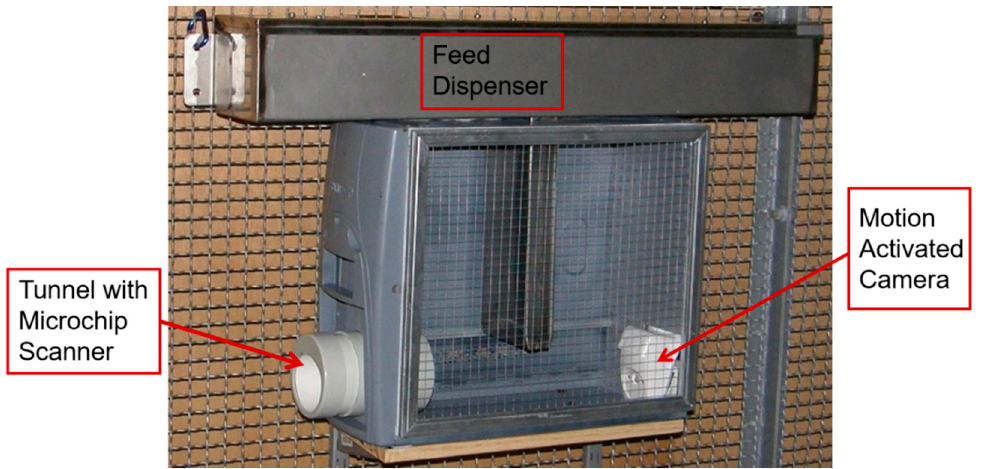
Figure 9. Prototype microchip feeder developed for use with captive owl monkeys in 2007 (Photo: J. Hoy).